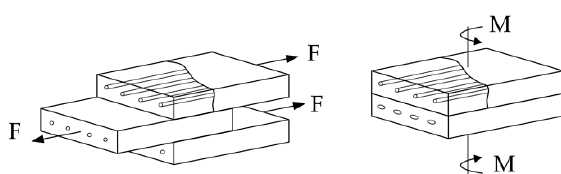
Figure 17. Inter-ply forming mechanisms (Inter-laminar slip and inter-laminar rotation / shear).